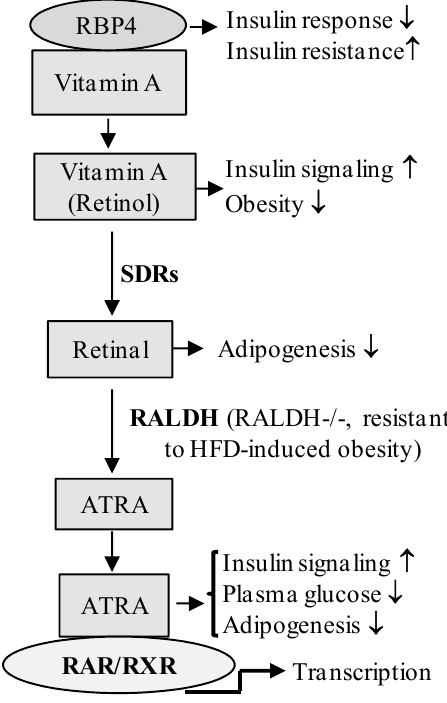
Figure 3. Retinoid-mediated signaling in the regulation of glucose/lipid metabolism. The schematic diagram represents the involvement of retinoid signaling components in the regulation of glucose/lipid metabolism in the development of obesity and diabetes.